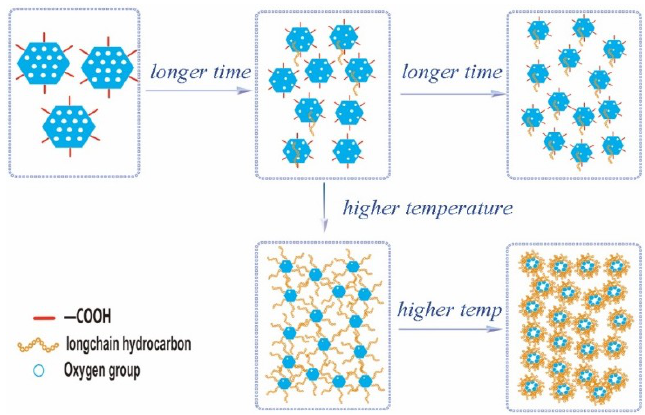
Scheme 4. The evolution of RGO under different reaction conditions.